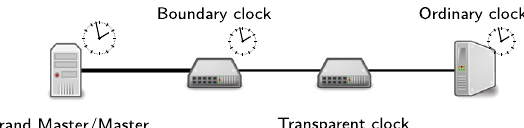
Fig. 2 PTP hierarchy. The clock symbol specifies which nodes are synchronized each other using